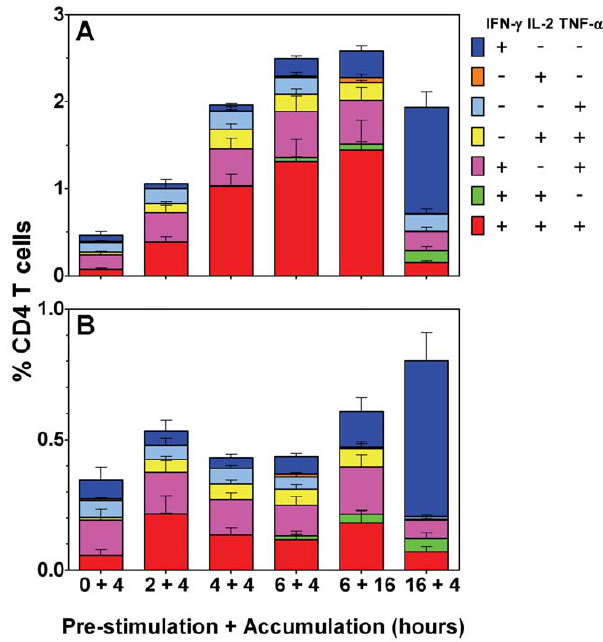
Figure 2. The effect of different culture schedules on antigen- specific murine CD4 T cell responses. Six weeks following immunization, spleen cells from BCG or placebo control vaccinates were isolated, stimulated with a BCG derived recombinant protein cocktail (A) or individual immunodominant peptide of Rv0288 (B), stained by intracellular cytokine staining (ICS) and interrogated by flow cytometry. Plots were gated on live CD4 + lymphocytes and analyzed for all combinations of simultaneous IFN- c , IL-2 and TNF- a productivity. The stacked bar graphs represent the percentage of antigen-specific CD4 + cells in the seven individual cell subsets, data are representative of one of three independent experiments (n=6). Bars represent the mean 6 SEM.